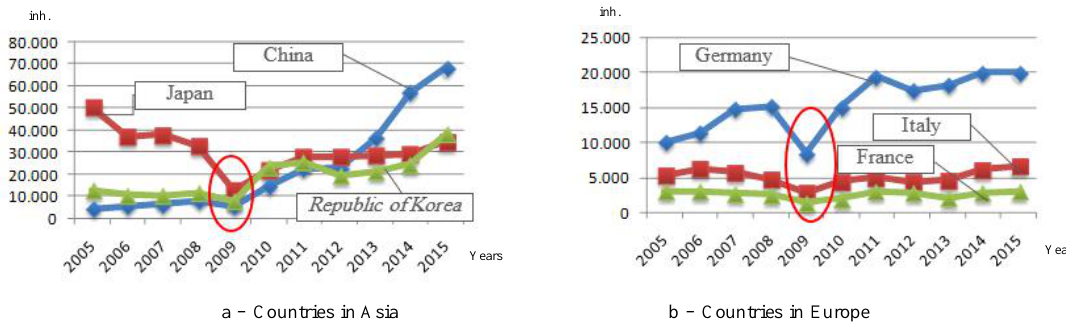
Fig. 3: Annual and total representation of industrial robots in the countries in Asia (China, Japan and Republic of Korea) and the countries in Europe (Germany, Italy and France)